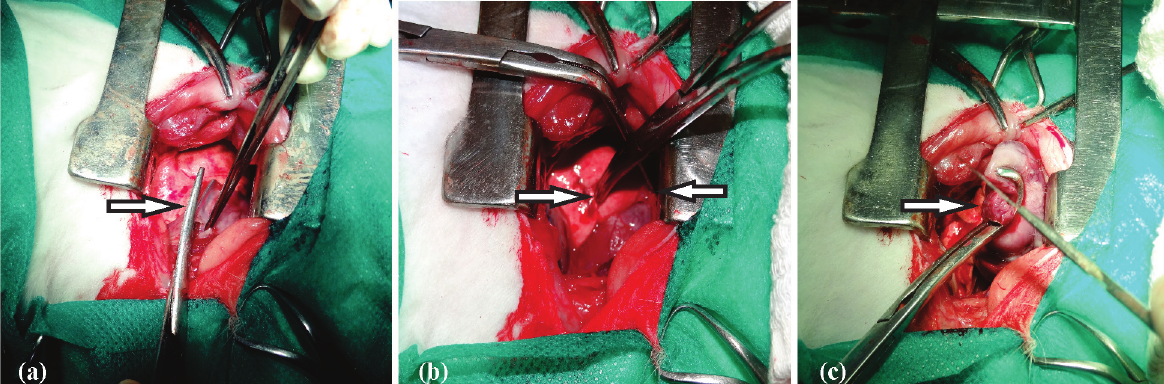
Figure 1 – Application of Inflow occlusion technique. ( a ) Pericardium space opening to access the heart. ( b ) Occlusion of cranial and caudal vena with vascular clamps, at the moment of ischemia. ( c ) Clamping of the left ventricle and cardiac